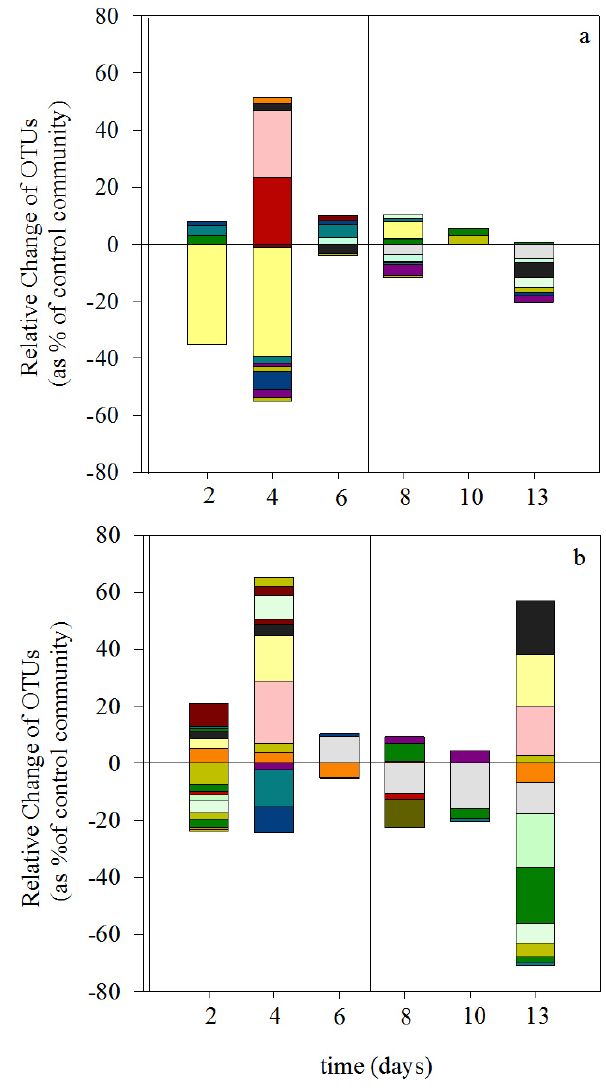
Figure 4. Changes in the relative abundance of total (a) and ac- tive (b) OTUs in response to dust addition at 5m depth during the DUNE-R experiment. Positive changes indicate higher, and nega- tive changes indicate lower relative abundance in dust than in con- trol mesocosms. Changes in relative abundances are expressed as percent of the total community. Only OTUs with significantly dif- ferent relative abundances in the dust and control-mesocosms are shown. See Material and Methods for more